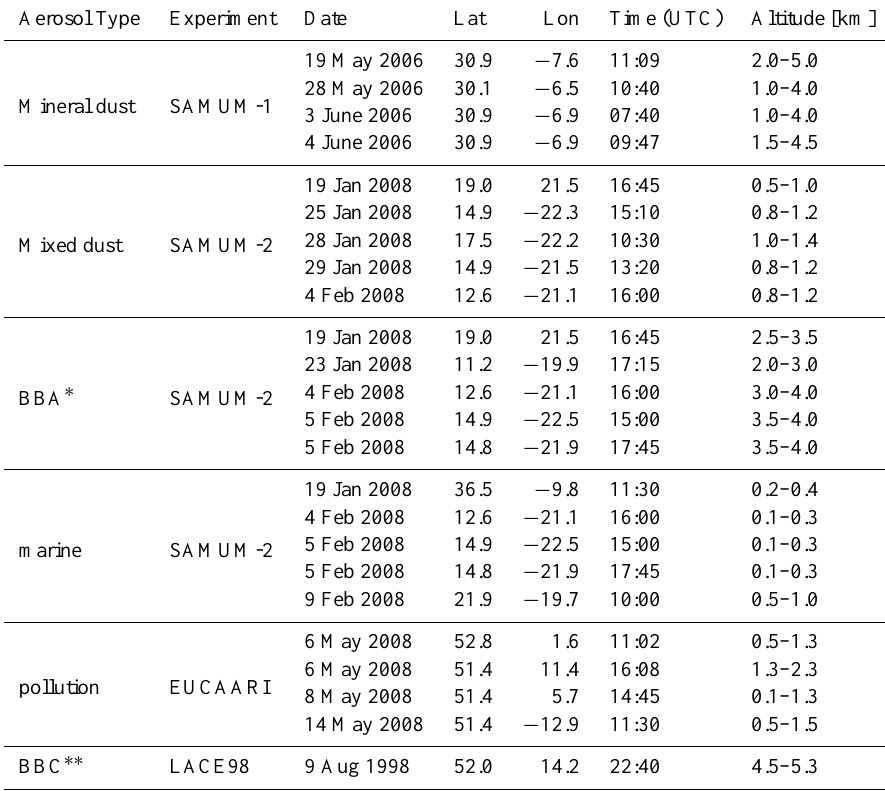
Table 1. Detailed information about analyzed case studies used for the aerosol classification concerning aerosol type, measurement experi- ment, date, location, time and altitude range of